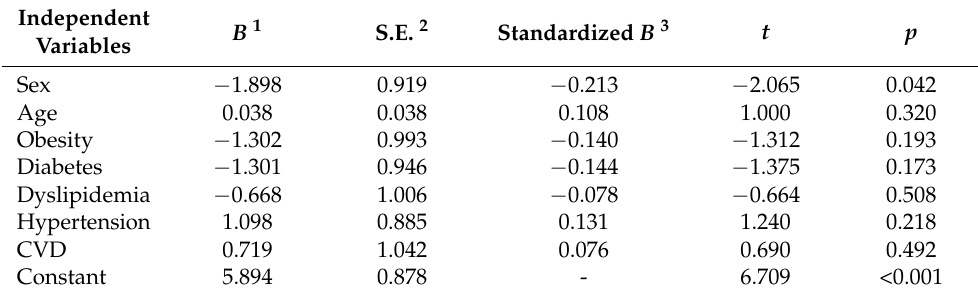
Table 4. Results of multilinear regression model ( stepwise ) that was designed using the number of days between the dates of a positive COVID-19 test result and hospitalization (inpatient admission) as the dependent variable.